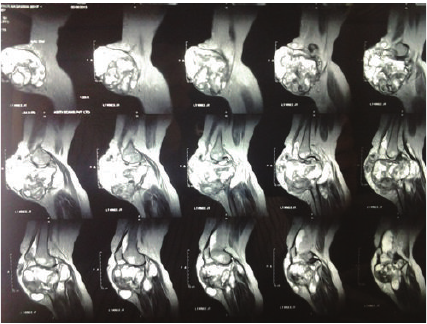
Figure 3: MRI of the right knee